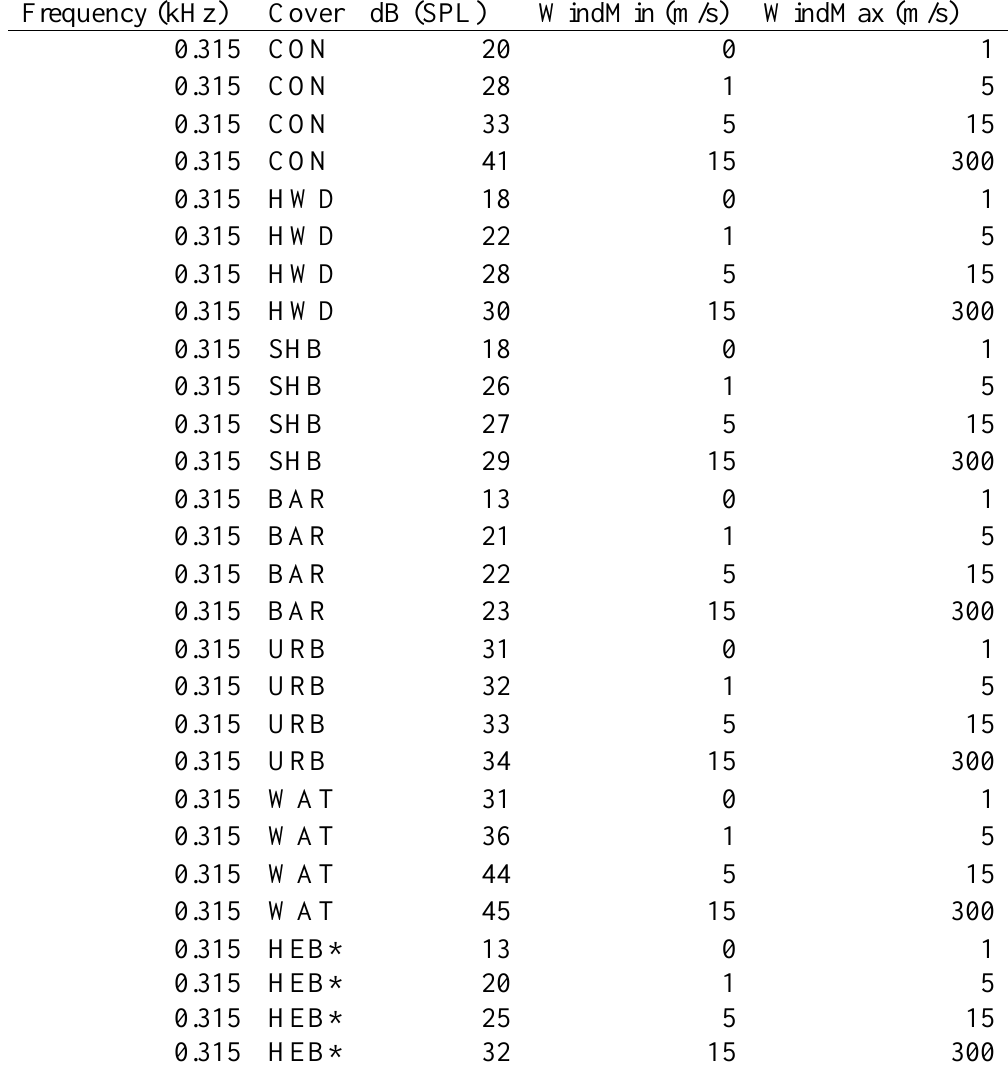
Table A1.2. Example background sound table for SPreAD-GIS from lek recordings on 4/06/2013 at lek A1 near Ainsworth, Nebraska. Land cover (dB) extrapolated from ANSI 2004 and Harrison et al. 1980. Cover derived from National Landcover Database: conifer (CON), hardwood (HWD), shrub (SHB), barren (BAR), urban (URB) and wetlands (WAT). *Herbaceous (HEB) grassland dB are average background sound level in a five-minute recording within same range of wind